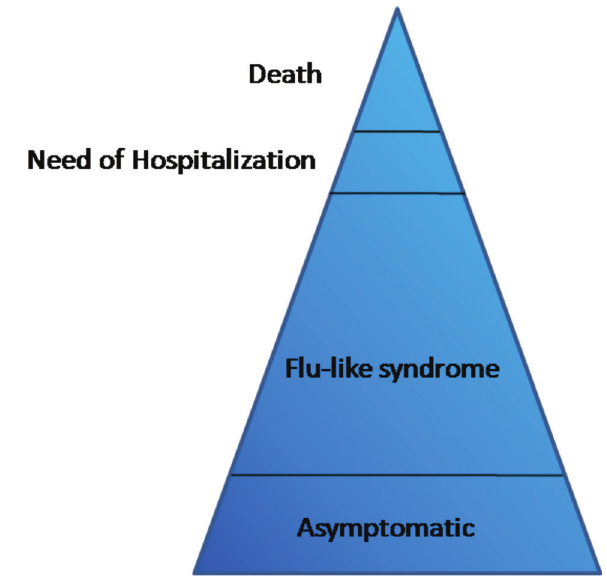
Figure 1 - Spectrum of novel influenza A (H1N1)